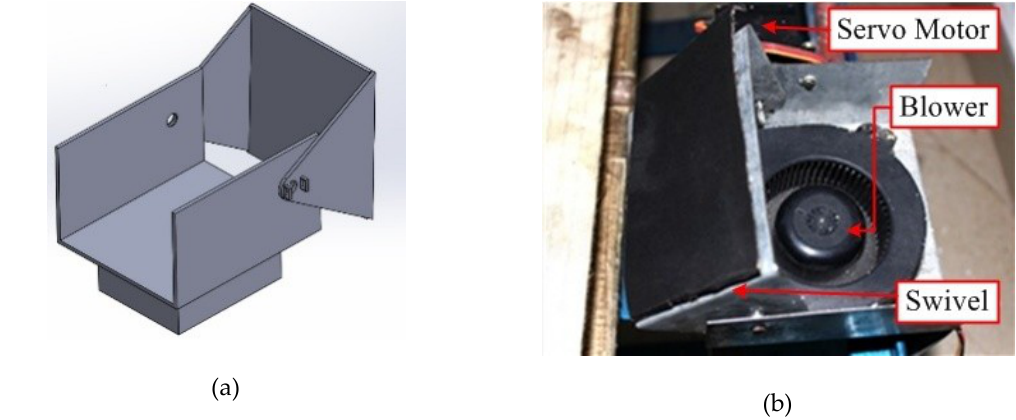
Figure 10. ( a ) 3D model of air blower frames; ( b ) developed air blower mechanism.